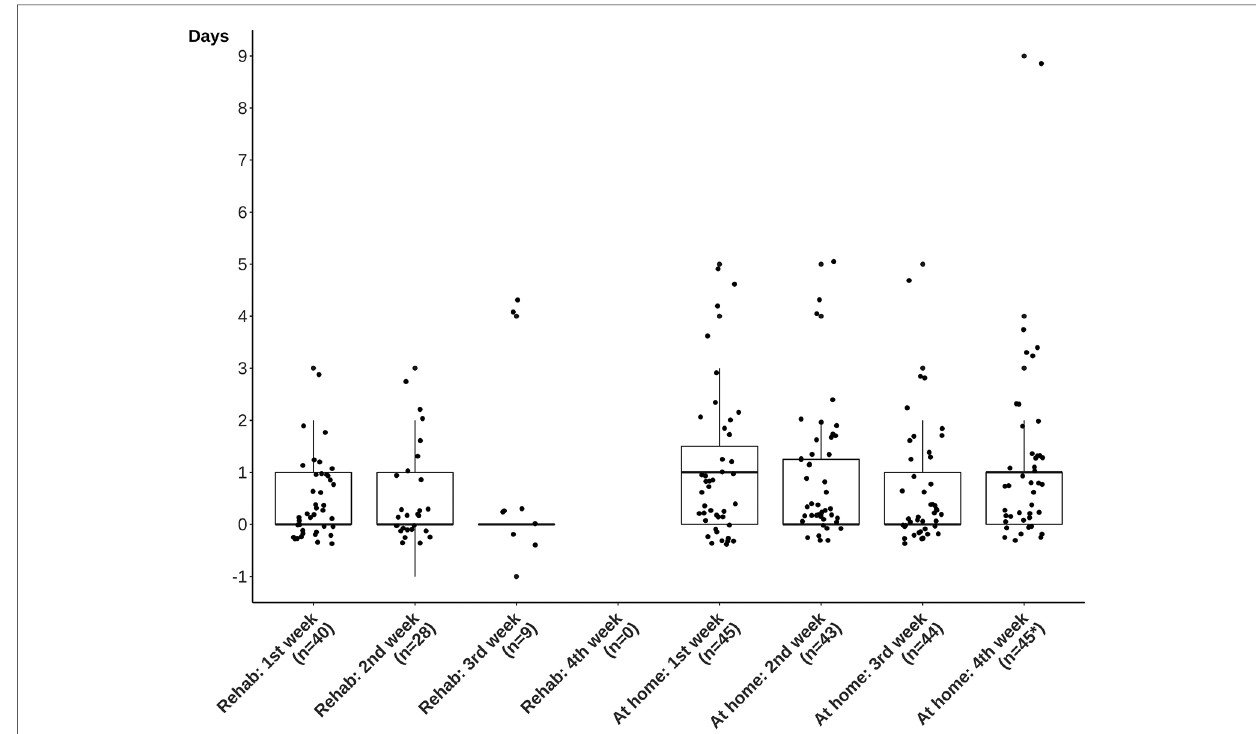
FIGURE 1 Time elapsed between the invitation and completion of the different surveys study participants had to complete on their own. The “ baseline ” and “ end of rehabilitation ” surveys were completed together with the person of contact in the rehabilitation clinic and are therefore not displayed. Due to technical issues, twice a survey was completed a day before the invitation was sent out ( “ Rehab: 2nd week ” and “ Rehab: 3rd week ” ). * Three outliers were not displayed for readability reasons. The values of these outliers were 26, 39, and 46